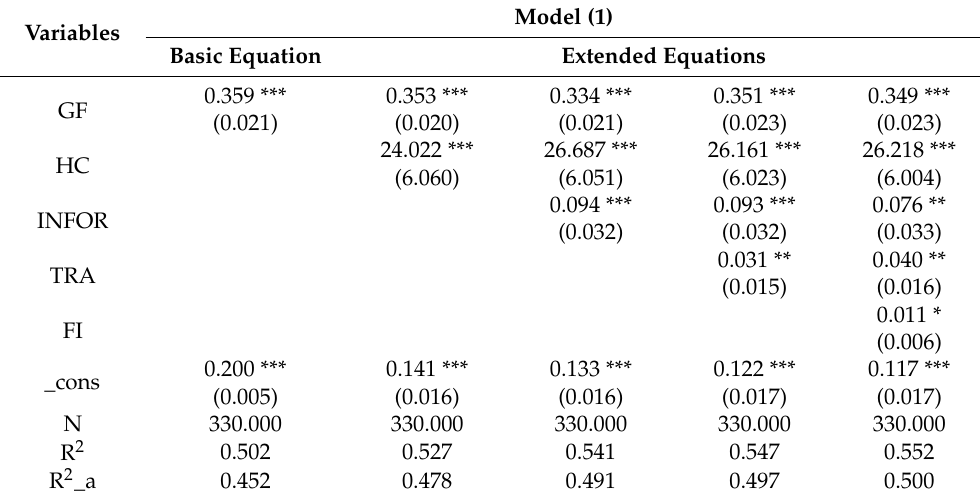
Table 4. Basic regression results of green finance on the quality development of the economy.